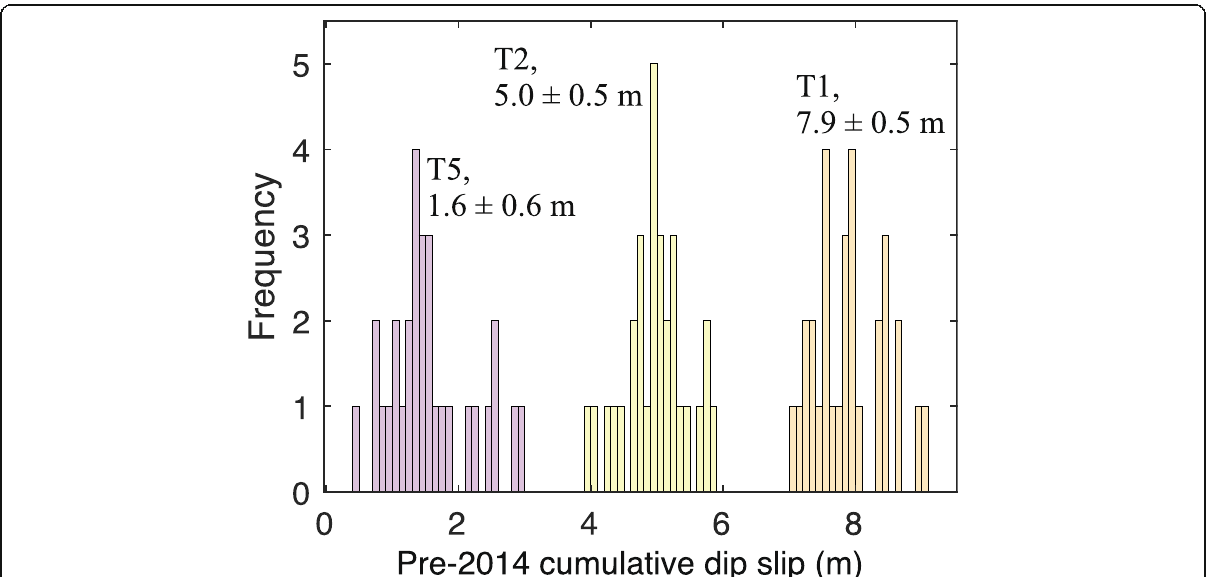
Fig. 9 Histograms of the cumulative dip slip of terraces T1, T2, and T3 calculated by the MCSST. The amount of slip shown in this figure does not include that of the 2014